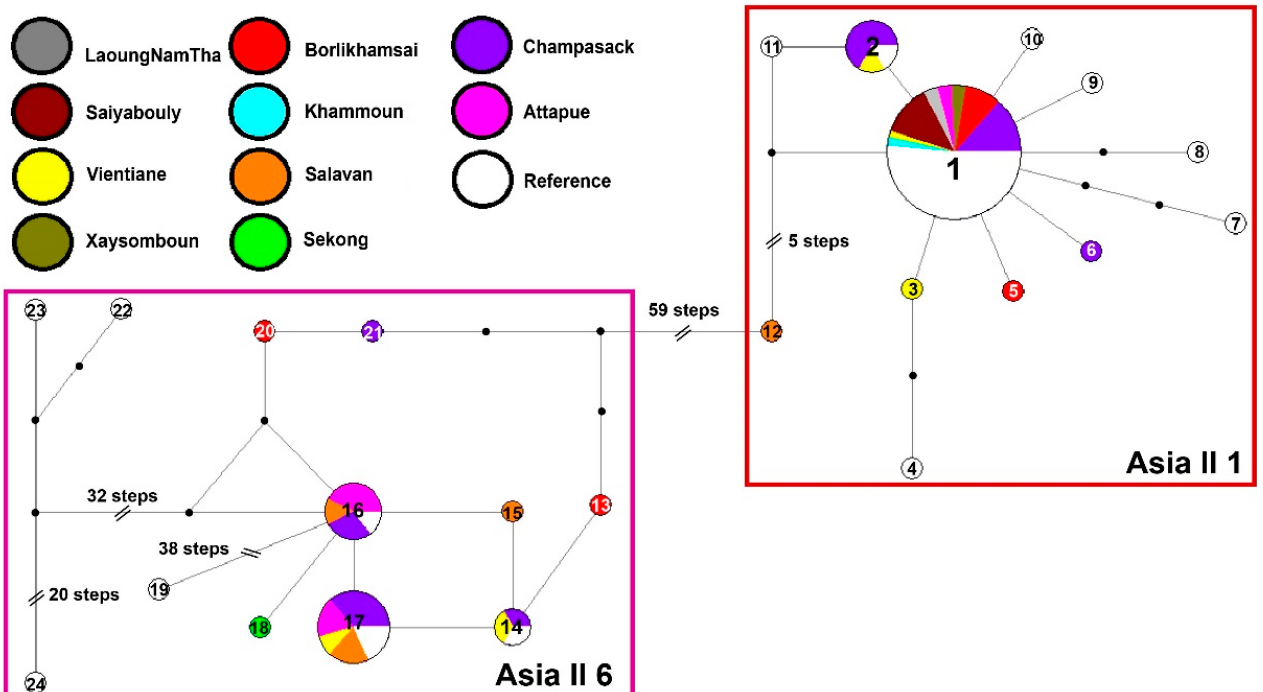
Figure 3. Haplotypes obtained from Median Joining with Network Software. Twenty-four mitochondrial cytochrome oxidase I haplotypes from 104 individuals of Asia II 1 and Asia II 6 are observed. The area of the circles is proportional to haplotype frequency in the dataset. The geographical region of each haplotype is color-coded and the small black circles indicate mutational changes.